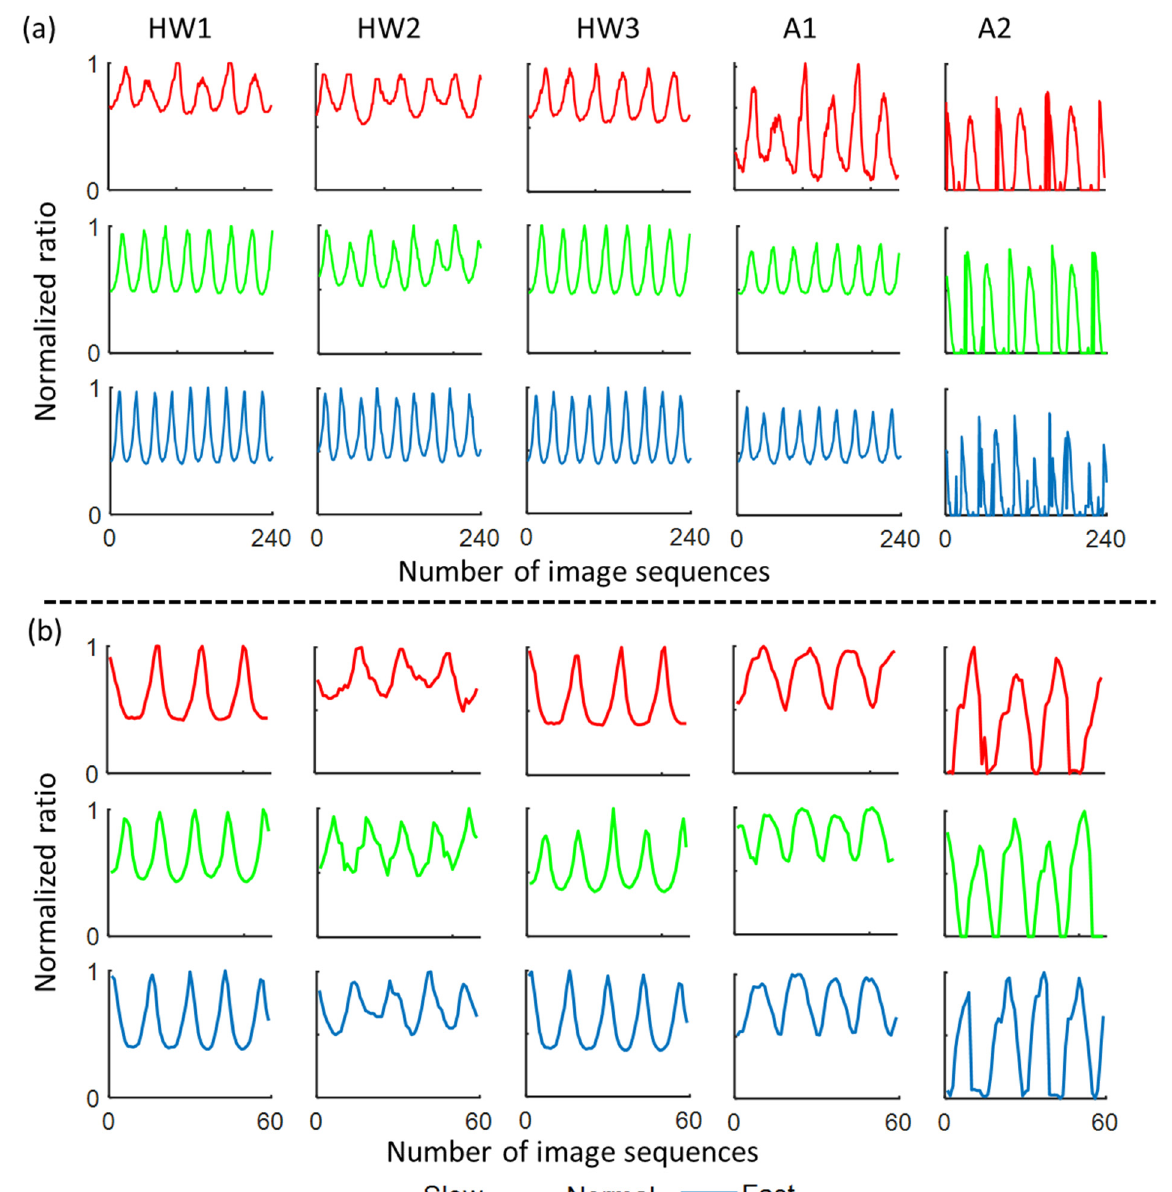
Figure 2. Quasi-periodic signals produced by the five ratio-based body measurements estimated from image sequences from one individual walking at three different speeds included in ( a ) OU-ISIR dataset A and ( b ) CASIA dataset C. Here, HW1—ratio of the full-body height to the full-body width; HW2—ratio of the full-body height to the mid-body width; HW3—ratio of the full-body height to the lower-body width; A1—ratio of the apparent to the full-body area; A2—ratio between area between legs and full-body area.